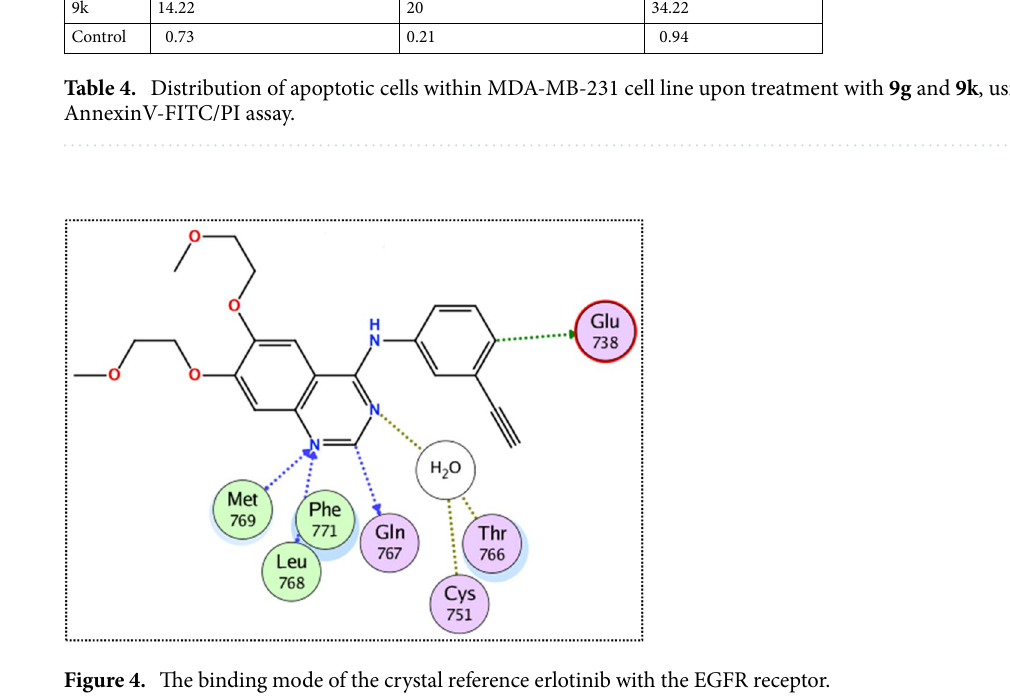
Figure 4. The binding mode of the crystal reference erlotinib with the EGFR